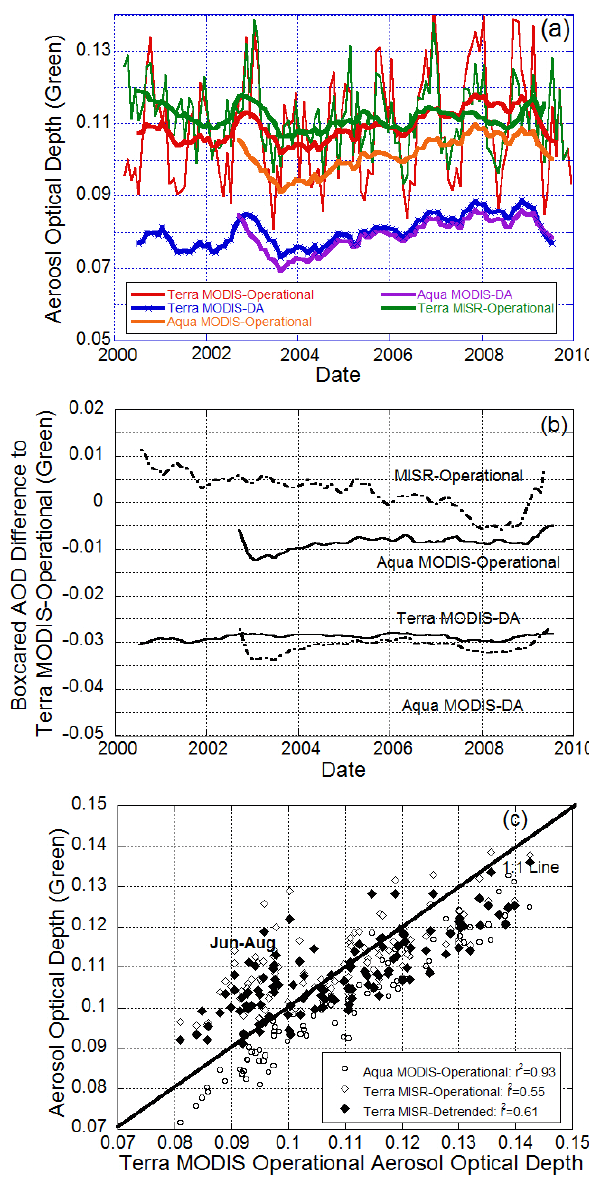
Fig. 5. (a) Similar to Fig. 2a but for the ten-year AOD trend analysis over remote oceans (RO, 0 ◦ –40 ◦ S, 180 ◦ W–140 ◦ W) us- ing the Terra MODIS (operational, dark red), Terra-MISR (green), Aqua MODIS (operational, light red), the DA quality Terra MODIS (blue), and the DA quality Aqua MODIS (purple) over water aerosol product. (b). Similar to Fig. 2b, but for the ten-year trend over the remote ocean region. (c). Similar to Fig. 2c, but for the remote ocean